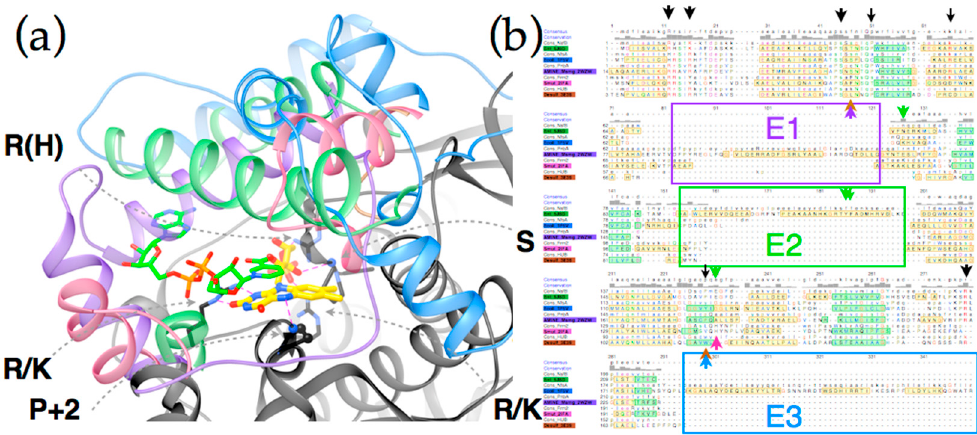
Figure 6. Comparison of the different substrate binding cavities, and their different origins in the sequences of PnbA (purple), NfsB (green), NfsA (blue) and Frm2 (pink). Panel ( a ) shows the contrast between exposed flavin binding pocket provided by conserved core structure (black) vs. enclosed substrate binding cavities formed by the distinguishing structures of the different subgroups. A map of amino acid conservation onto backbone structure for each of the current five subgroups is provided as Supplementary Figure S8. Core structure interactions that appear to stabilize FMN binding are indicated by grey dashed arrows. R(H) means Arg but sometimes His, R/K means Arg or Lys, P + 2 means that the second residue after a Pro contributes the interaction, S means Ser. The FMN from NfsB is included in yellow and an NADH analog bound to the NfsB model is in green, both with non-C atoms coloured by atom [50]; ( b ) Shows an alignment of consensus and representative sequences from each of these subgroups and HUB (brown label). The three insertions/extension in the sequence giving rise to the distinguishing structure are in boxes colored according to the subgroup in which it is best developed and labeled ‘E1’, ‘E2’ and ‘E3’ as per Akiva, Copp et al [41]. Yellow shading denotes alpha helices and green denotes beta strands. Black arrows indicate the locations of core residues interacting with the FMN, and arrows colored according to the above subgroup identify residues mentioned in the text as possibly constraining substrate binding and/or modulating flavin activity. A larger multi-sequence alignment is provided as Supplemental Figure S9 and those of the subgroups